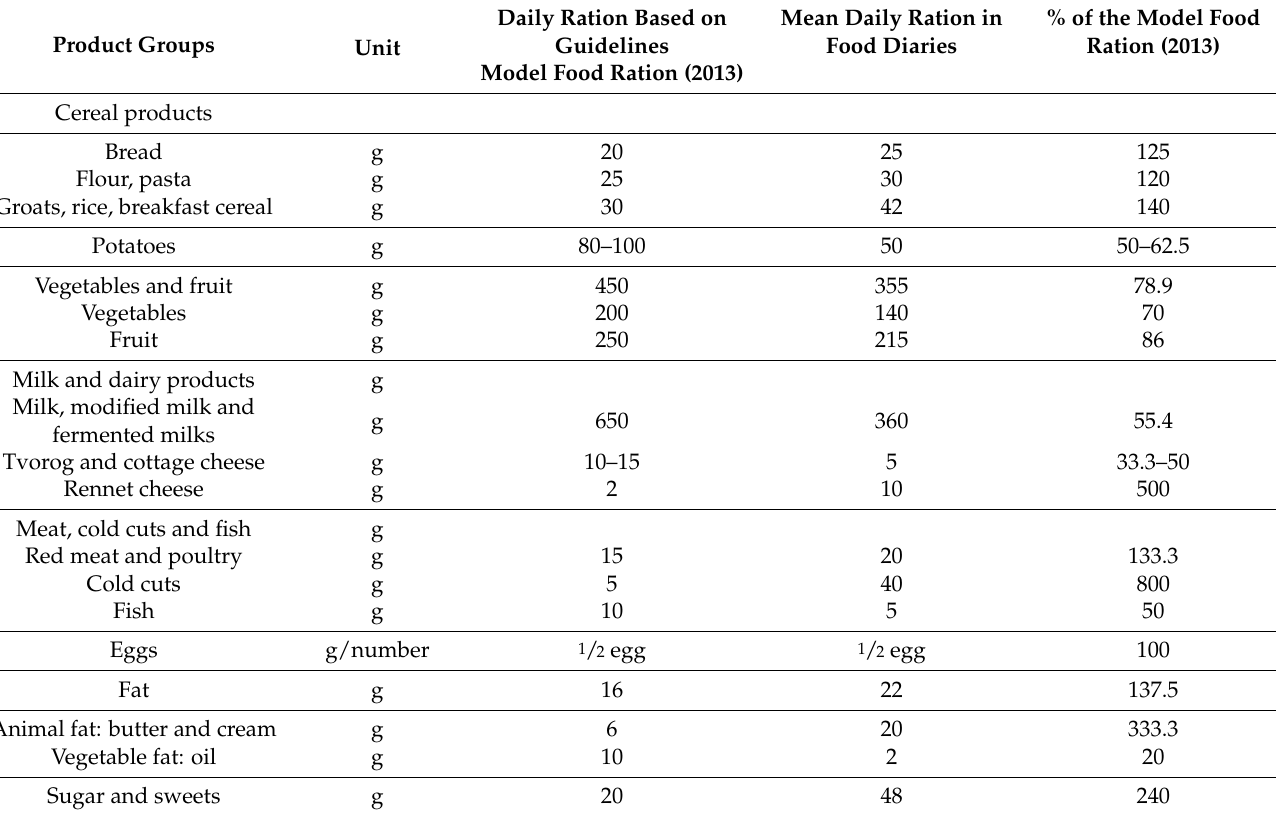
Table 2. The recommended daily ration for children aged 13–24 months and the mean daily intake of various food products in the analyzed food